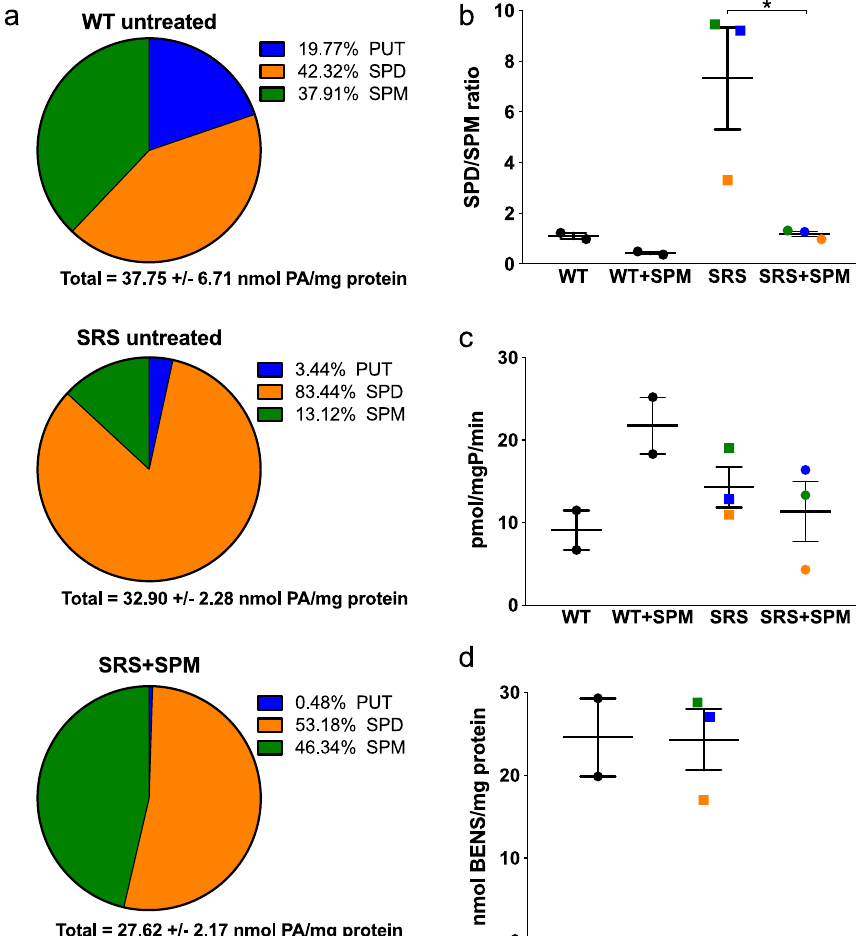
Figure 6. ( a ) Average polyamine levels of SRS lymphoblast lines before (middle) and after (bottom) 5 µ M SPM treatment for 24 h, compared with untreated WT lymphoblast lines (top). ( b ) SPD/SPM ratios and ( c ) SSAT activity before and after SPM supplementation. ( d ) Intracellular accumulation of bis(ethyl)norspermine (BENSpm) following 10 µ M treatment for 24 h. Color designations in (b–d) are orange for SRS1, blue for SRS2, and green for SRS3. All error bars indicate SEM ( n ≥ 2, in triplicate; * p < 0.05).